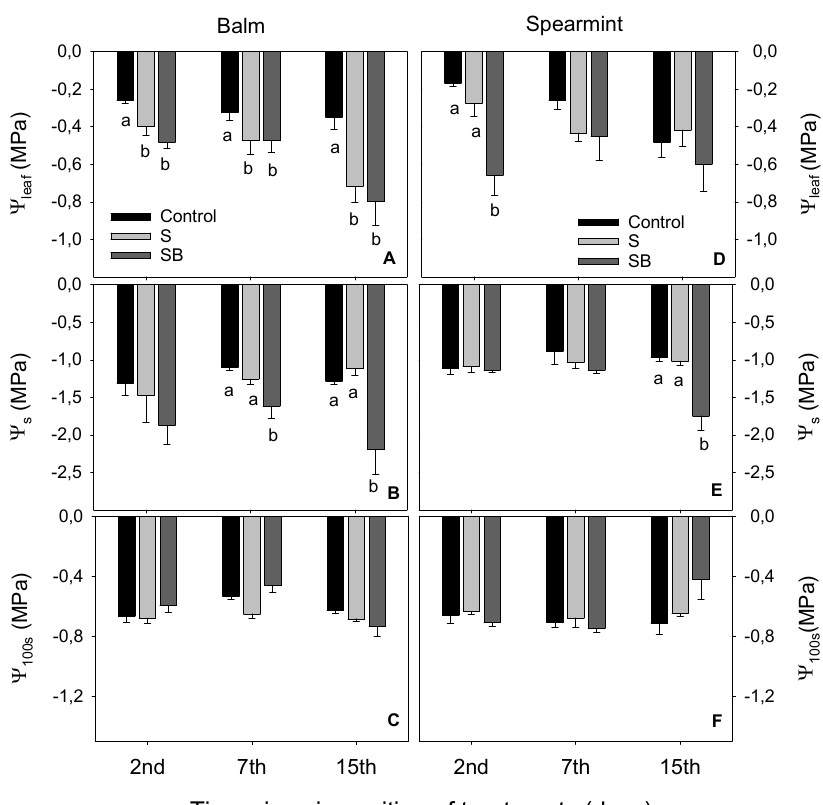
Figure 2. Leaf water potential ( Ψ leaf) ( A , D ), osmotic water potential ( Ψ os) ( B , E ) and osmotic water potential at full turgor ( Ψ 100s) ( C , F ) in balm and spearmint plants irrigated with water from different sources. Bars without lowercase letters mean no significant differences between treatments. Different lowercase letters indicate significant differences between treatments according to Duncan’s test at p ≤ 0.05.